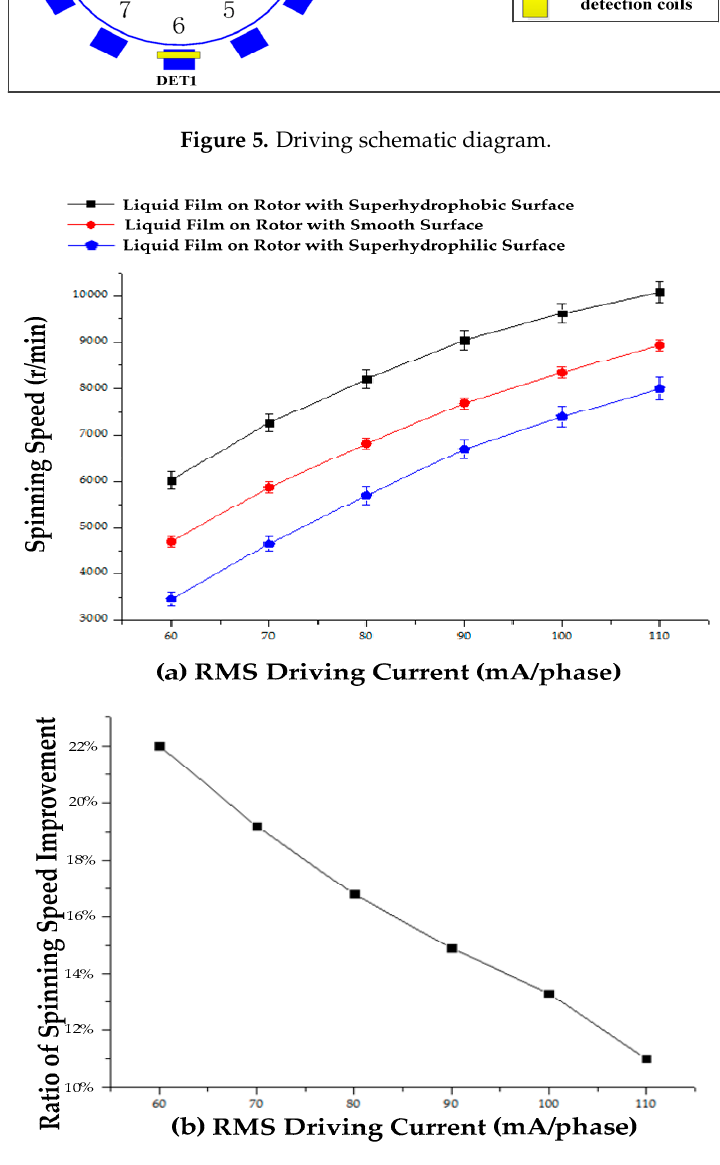
Figure 6. ( a ) Steady-state spinning speed under different RMS driving currents; ( b ) The ratio of the spinning speed improvement compared between rotor with smooth and superhydrophobic surfaces under different RMS driving currents.